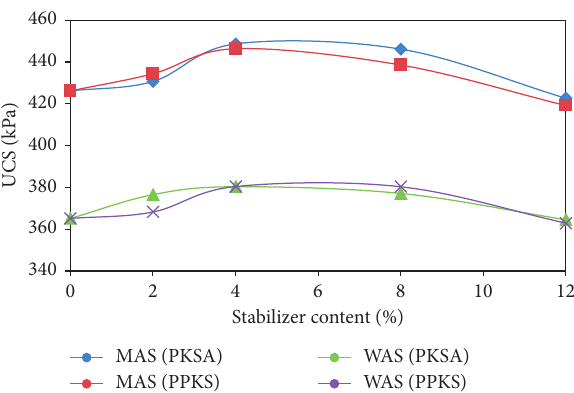
Figure 9: Compressive strength of the treated shale samples at MAS and WAS compactive